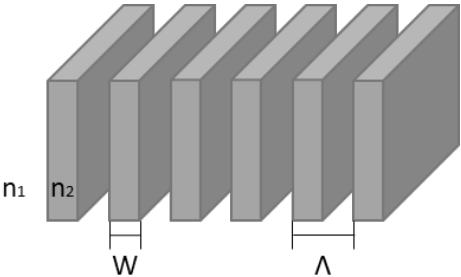
Figure 2. The grating structure and the parameters used in calculating the effective refractive index, n eff . The grating slabs are illustrated by the gray blocks.